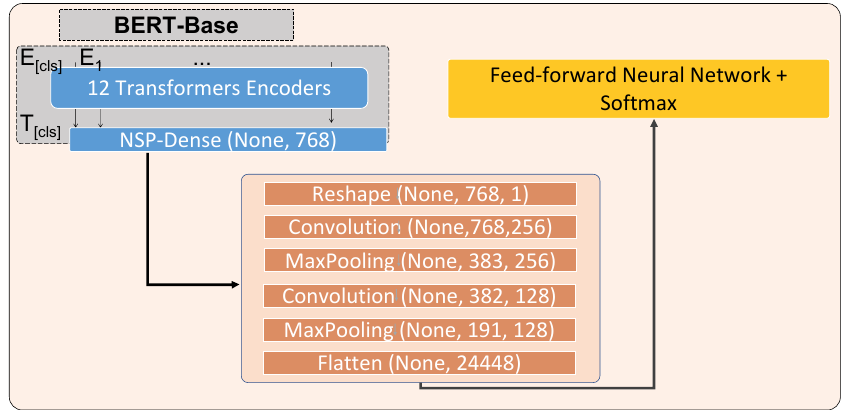
Figure 5. Optimal architecture for ClaimsBERT components.